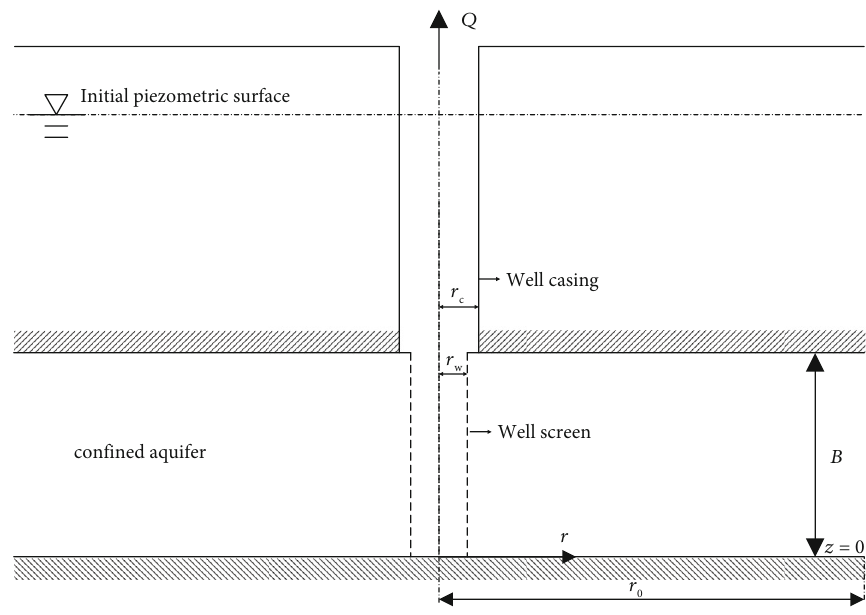
Figure 1: Schematic showing of a fi nite con fi ned aquifer